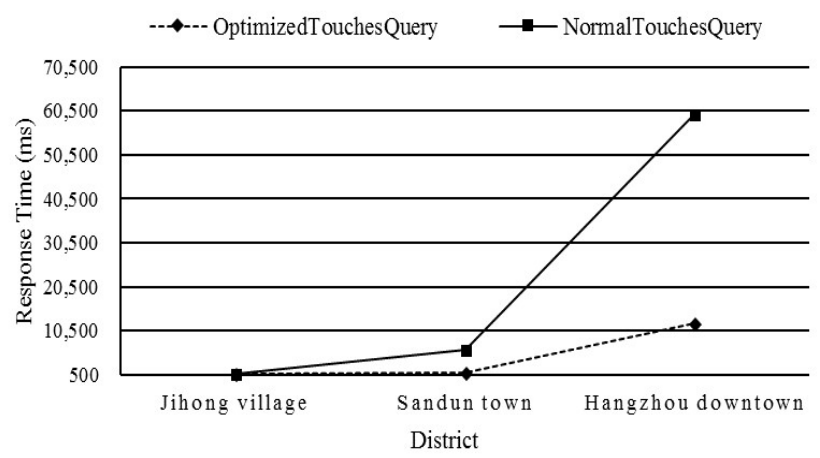
Figure 18. Touch query efficiency with the optimized strategy on spatial query operator.